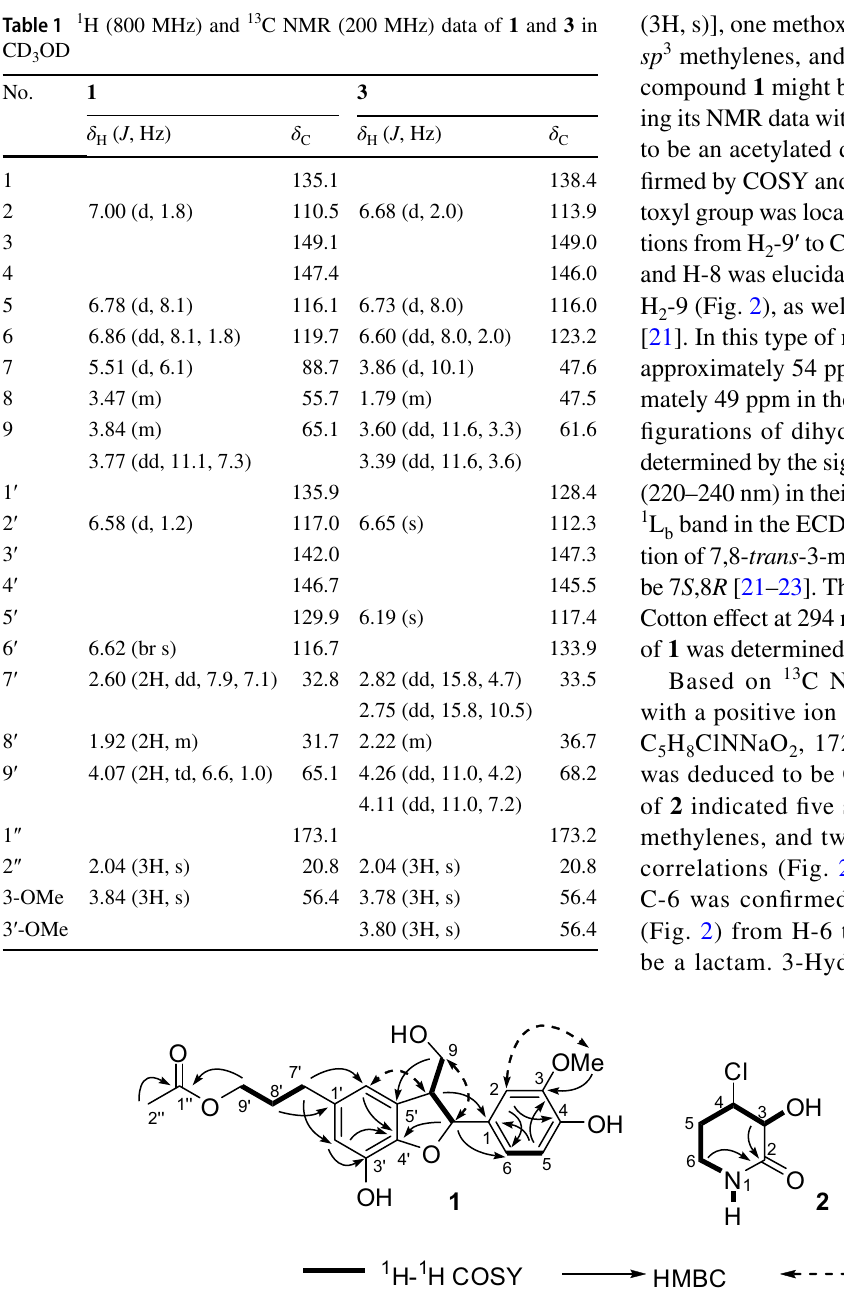
Fig. 2 Key 2D NMR correlations of compounds 1 and